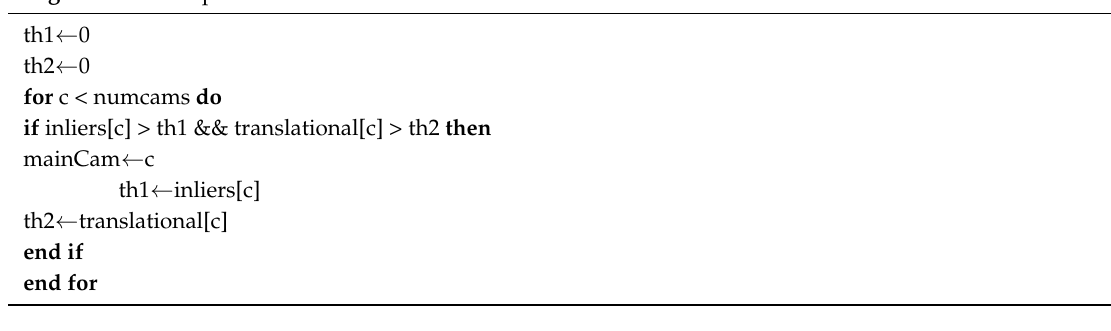
Algorithm 1. Adaptive selection of the main camera.